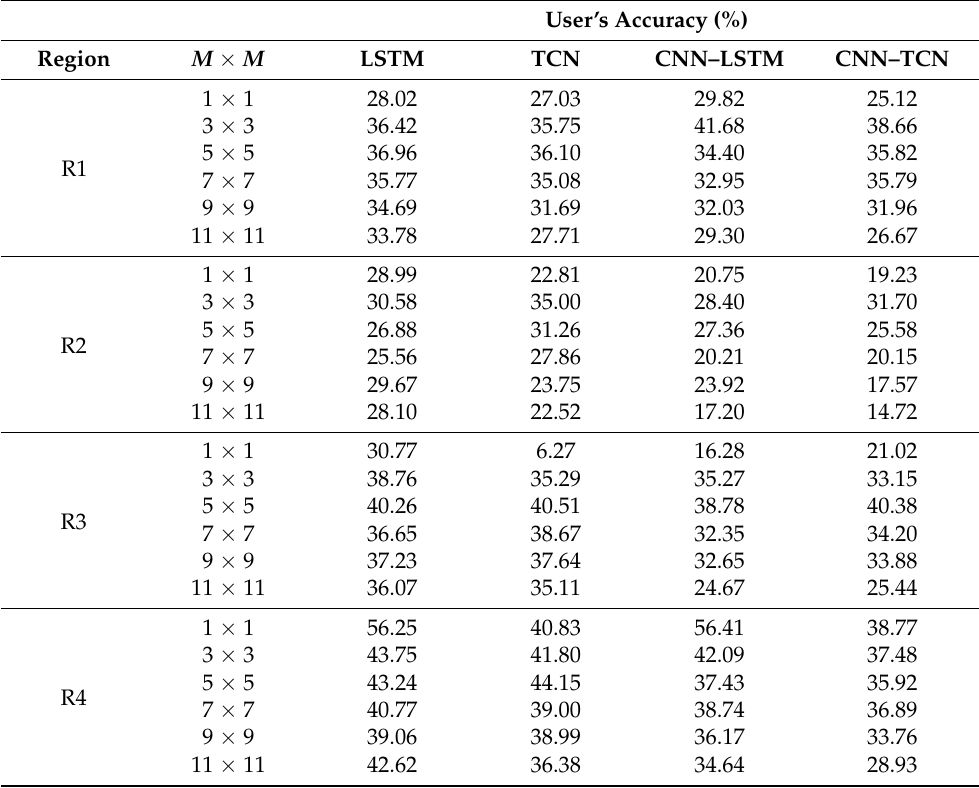
Table 6. User’s accuracy (UA) values obtained for (R1) the Regional District of Bulkley-Nechako, (R2) the Regional District of Central Kootenay, (R3) the Northern Rockies Regional Municipality, and (R4) the Cariboo Regional